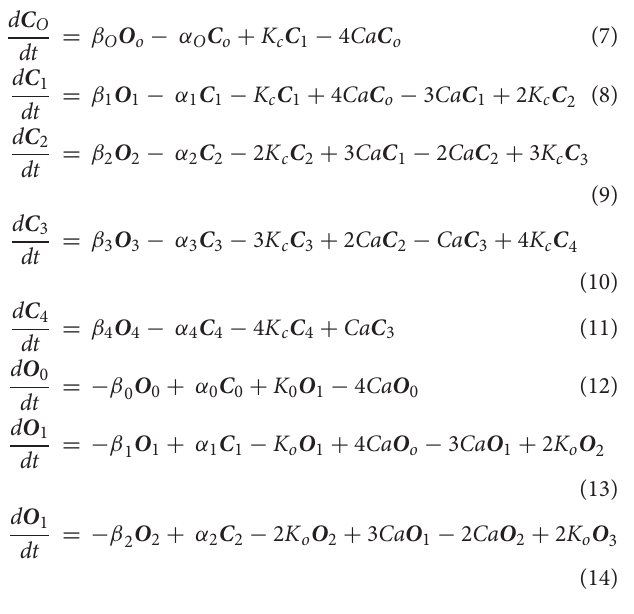
DR activated by voltage-clamp steps from holding potential of − 80mV − DR by (V-E K ), where E K is K + Nernst potential ( − 83mV). Data from −